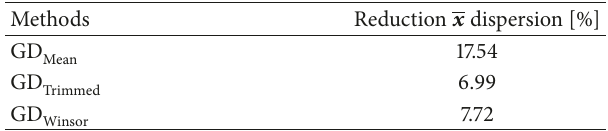
Table 23: Log-normal with 50 points.